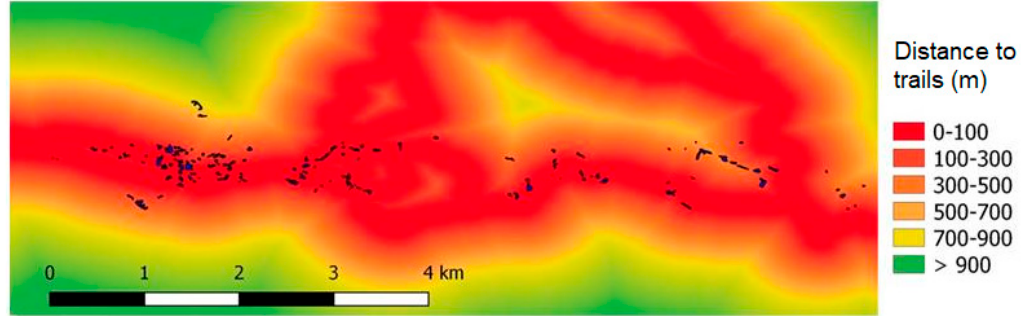
Figure 5. Distribution of A. chilensis forests that became diseased during 2007–2020 period (black spots) in relation to the distance to trails and paths. Color scale indicates the distance to trails across the study area. Forests 2020 , 11 , x